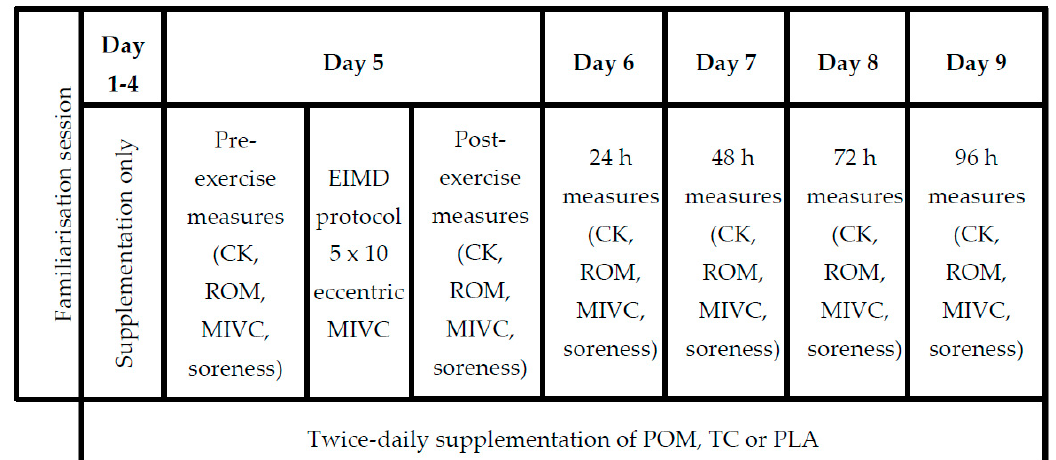
Figure 1. Timeline of study protocol from familiarization to 96-h post-exercise. POM = pomegranate; TC = tart cherry; PLA = placebo; EIMD = exercise-induced muscle damage; CK = creatine kinase; ROM = range of motion; MIVC = maximal isometric voluntary contraction.